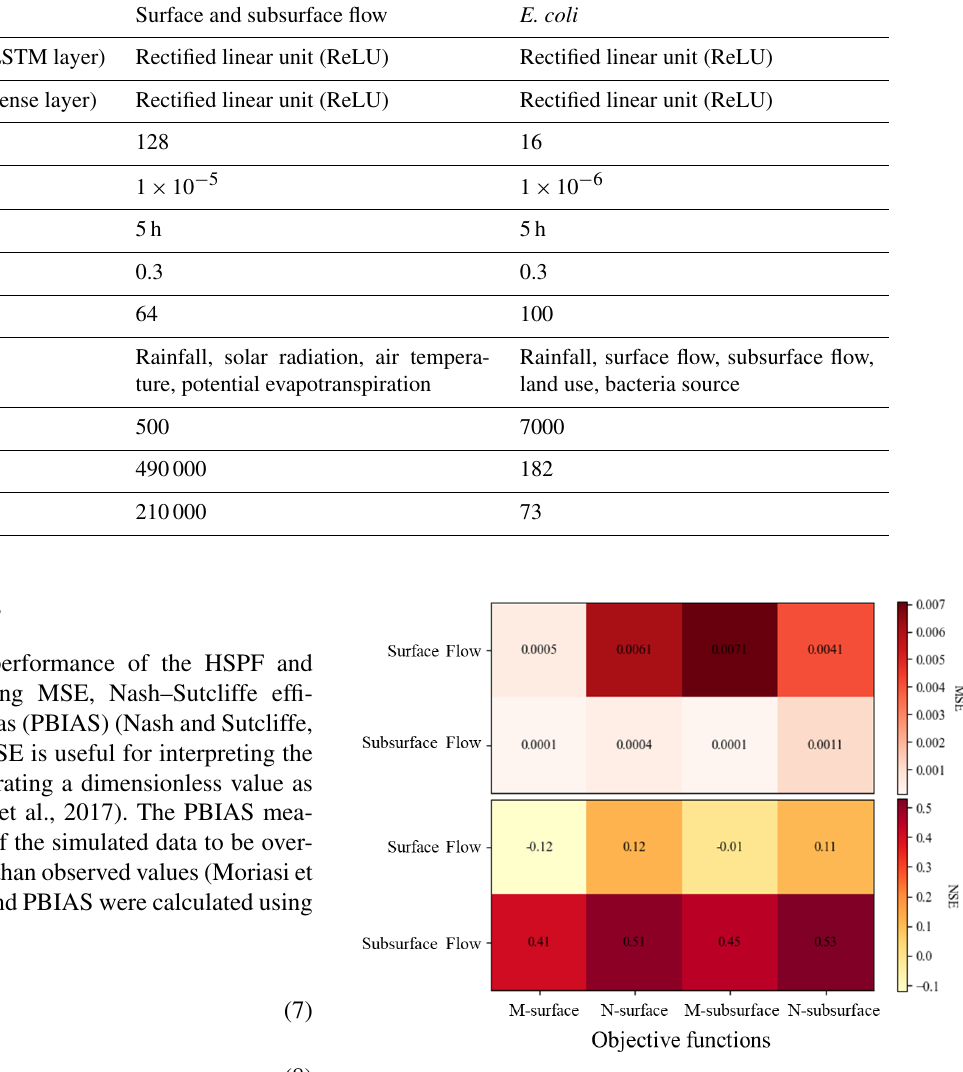
Figure 3. Performance of the HSPF model with different objec- tive functions (e.g., M-surface, N-surface, M-subsurface, and N- subsurface). The color indicates the value of MSE and NSE. M- surface is the objective function based on MSE and surface flow, N-surface is the objective function based on NSE and surface flow, M-subsurface is the objective function based on MSE and subsur- face flow, and N-subsurface is the objective function based on NSE and subsurface